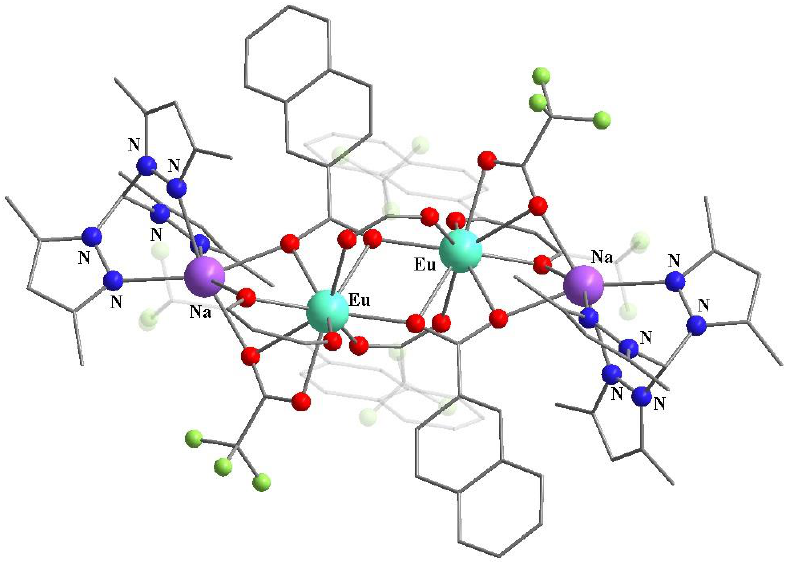
Figure 38. Molecular structure of 84 [126]. Some ligand groups are transparent for clarity. The cif has been retrieved from CCDC. CCDC number is 1008766. The synthesis of heterometallic [Ni-Ln] complexes ( 83 – 87 ) included the two steps: Schiff base interaction with nickel(II) nitrate followed by the Ln(hfac) 3 addition (Scheme 31) [127]. In that case, one fluorinated β -diketonate molecule from Ln(hfac) 3 underwent a retro-Claisen re- action to give the [Ni-Ln] complexes ( 85 – 89 ) with the trifluoroacetate anion as coligand (Figure 39).